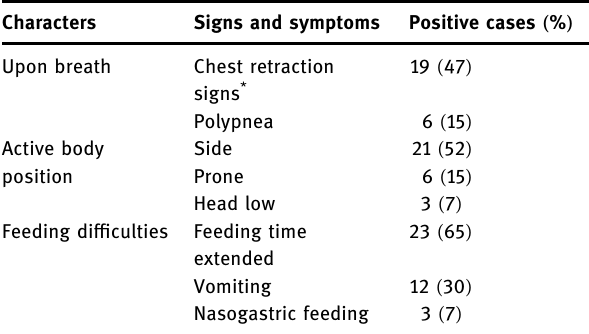
Table 1: Patient ’ s characteristics of preoperative breath and feeding di ffi culties ( n = 40